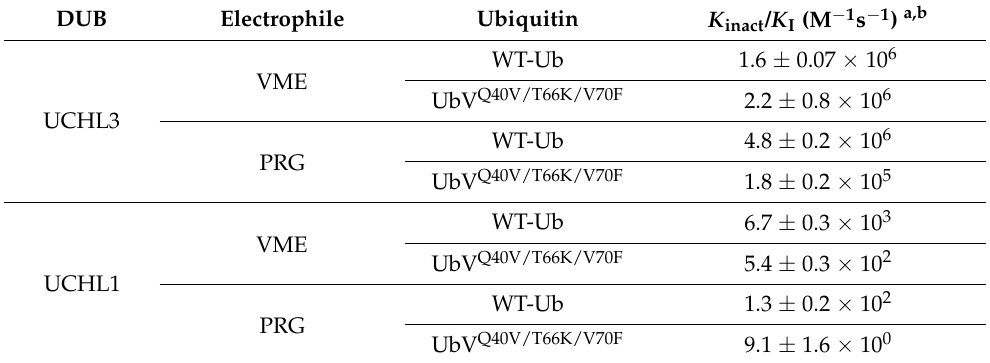
Table 2. Inactivation efficiency for WT- and triple-mutant UbV-ABPs versus UCHL3 and